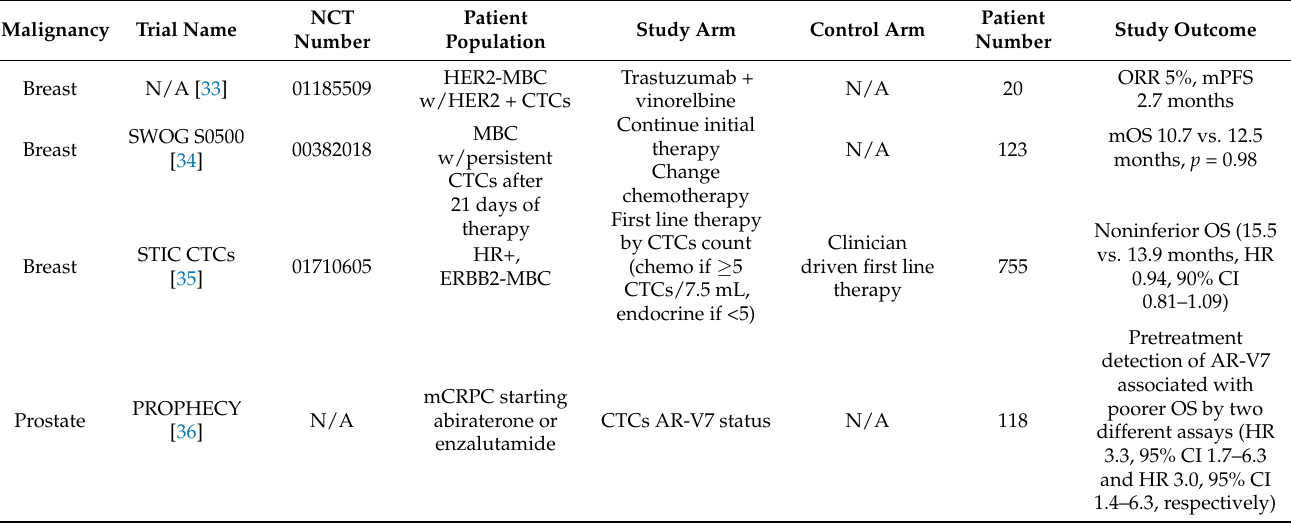
Table 2. Pertinent clinical trials evaluating the clinical application of